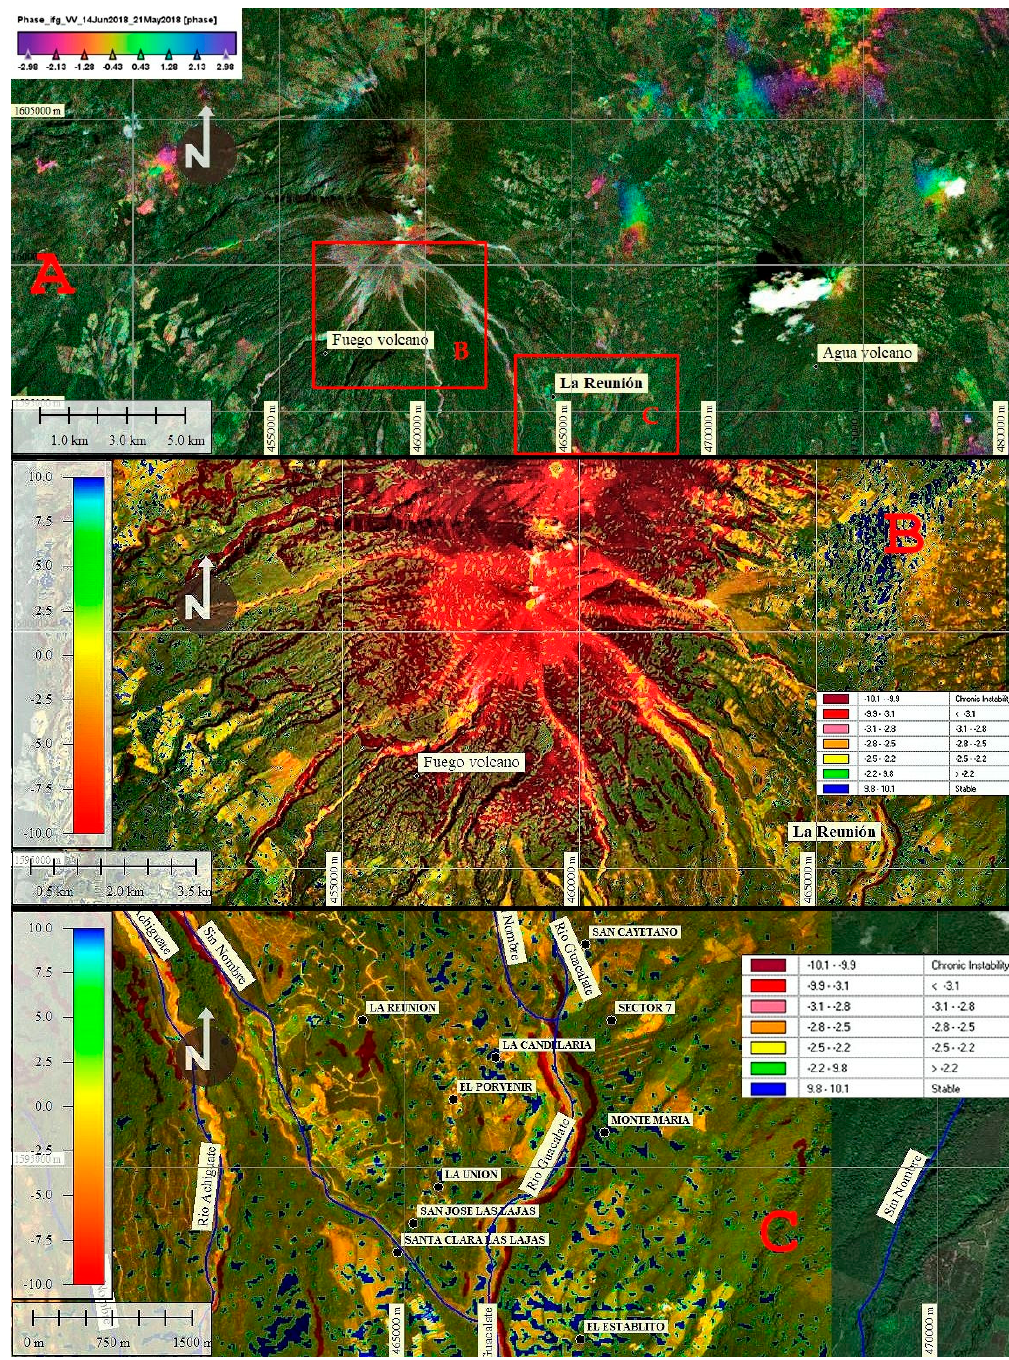
Figure 12. DINSAR analysis and SHALSTAB unstable and erosion areas. ( A ) Iridescent colors indicate the tendency of deformation in the region in cm. The positive values represent raised areas and the negative subsidence zones with minimal deformation in the volcano on the SE flank. ( B ) SHALSTAB results: the relief on the flanks of the volcano is very irregular with raised and sunken areas possibly due to the permanent morphological change resulting from the eruptions that have occurred. ( C ) Detail of the areas near the volcano that are the most unstable, with a rating of almost stable to chronic instability due to erosion of the channels that the lahars have flowed in, have overflowed and caused flooding with the destruction of the civil infrastructure mainly in El Rodeo, San Miguel, Monte Mar í a, and sectors near the Guacalate river. Negative red colors and trend towards –10 are unstable areas and stable positive zones with colors towards the blue and values with trend toward 10. The value is